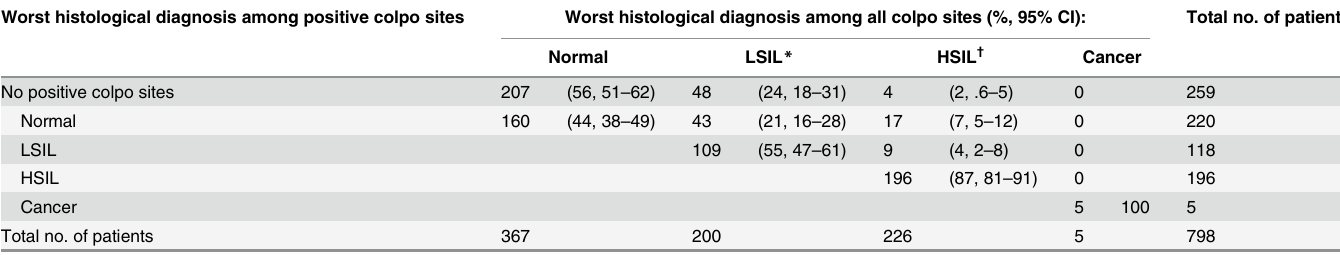
Table 3. Comparison of worst histological diagnosis among sites diagnosed as positive by colposcopy with worst overall histological diagnosis for the 798 diagnostic group patients. Worst histological diagnosis among positive colpo sites Worst histological diagnosis among all colpo sites (%, 95% CI):